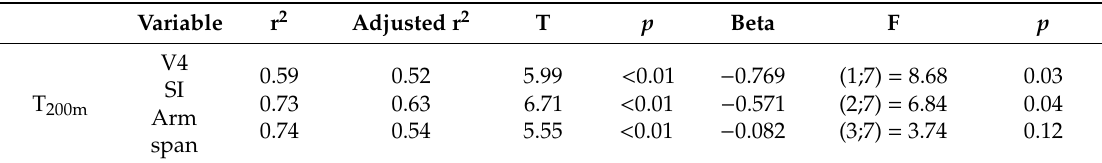
Table 3. Summary of the model, included in the forward step-by-step regression equation, for predictors of T 200m